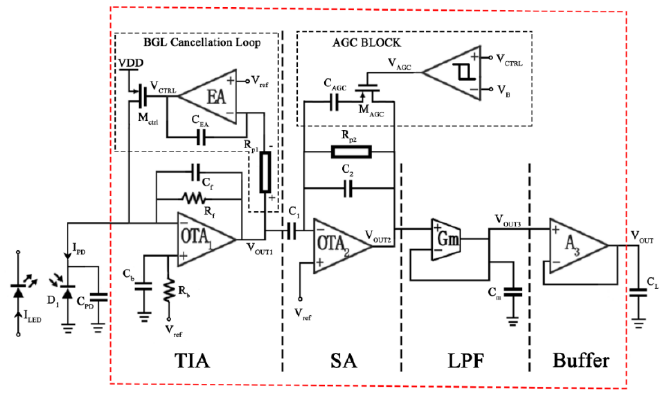
Figure 2. The proposed architecture of the Figure 2 . The proposed architecture of the AFE.